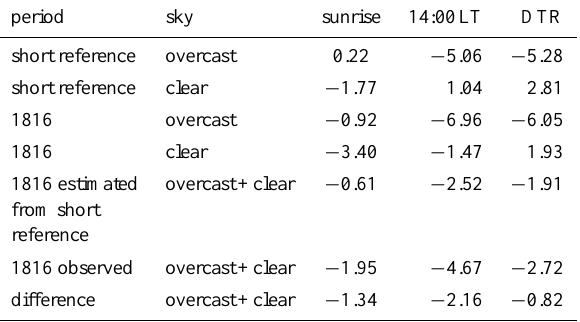
Table 1. Effect of clouds on temperature. Averaged summer- time (June–August) temperature anomalies ( ◦ C) at sunrise and at 14:00LT as well as their difference (diurnal temperature range, DTR) for days with clear sky (both sunrise and 14:00LT) or fully overcast days (both sunrise and 14:00LT) during a short reference period (1812–1814 and 1818–1821, i.e. the period with relatively reliable cloud observations) and in summer 1816. Row 5 shows the average temperature anomaly for the sum of overcast and clear days for 1816 assuming the mean values from the short reference in the first two rows and the number of fully overcast days (21) and fully clear days (15) from 1816. Row 6 is the same but using the mean values from the year 1816 itself. The lowest row shows the differ- ence between the two. All temperature anomalies are with respect to the long reference period.